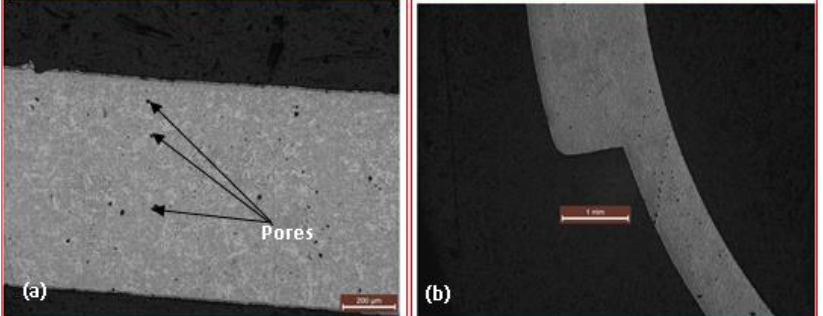
Figure 11: Optical microstructure of connector 1 for longitudinal (a) and transverse (b) sections in different magnifications. Un-etched.